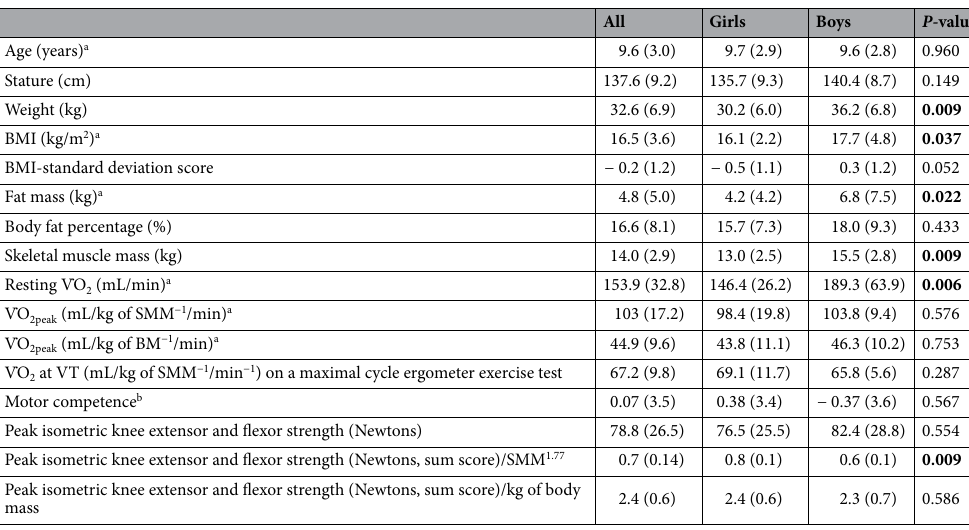
Table 1. Characteristics of participants. The data are mean (SD) or a median (IQR). V ̇ O 2peak was defined as the highest V ̇ O 2peak during running on a treadmill for 8 km/h, self-paced running, or on a maximal cycle ergometer exercise test; V ̇ O 2 = oxygen uptake; SMM = skeletal muscle mass. P values refer to statistical significance for differences between girls and boys with statistically significant differences bolded. b Motor competence score was computed using the sample specific KTK result z-scores.